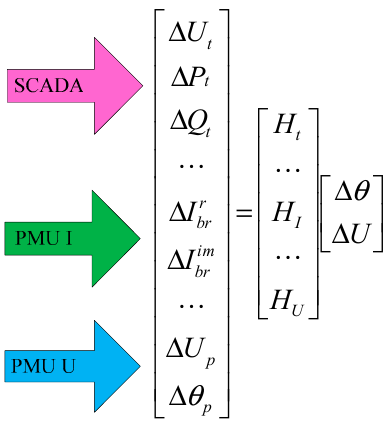
Figure 6. The mixed calculation model including PMUs.